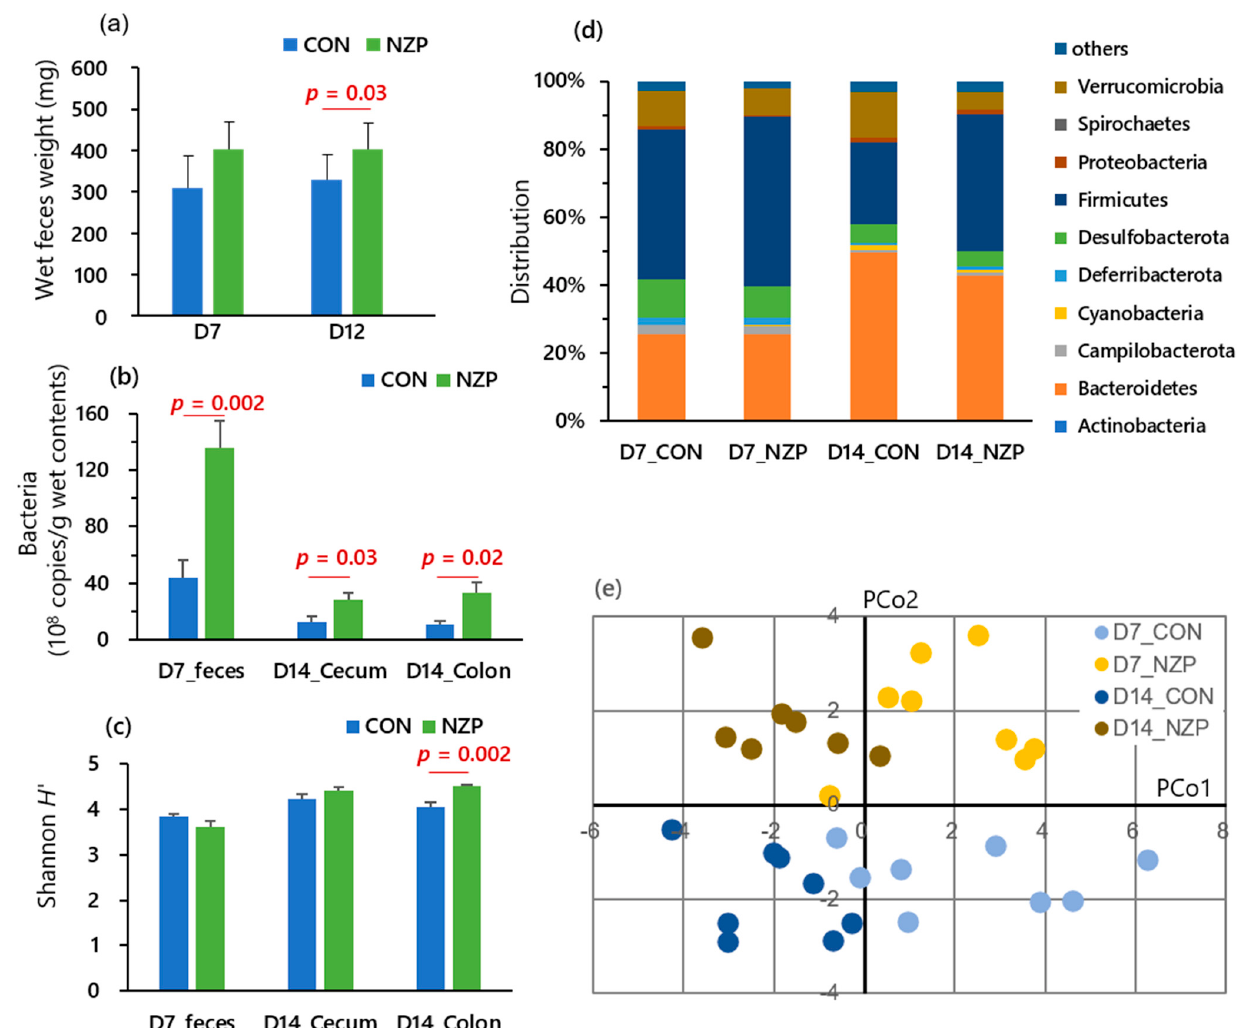
and NZP mice were determined using Student’s t -test.